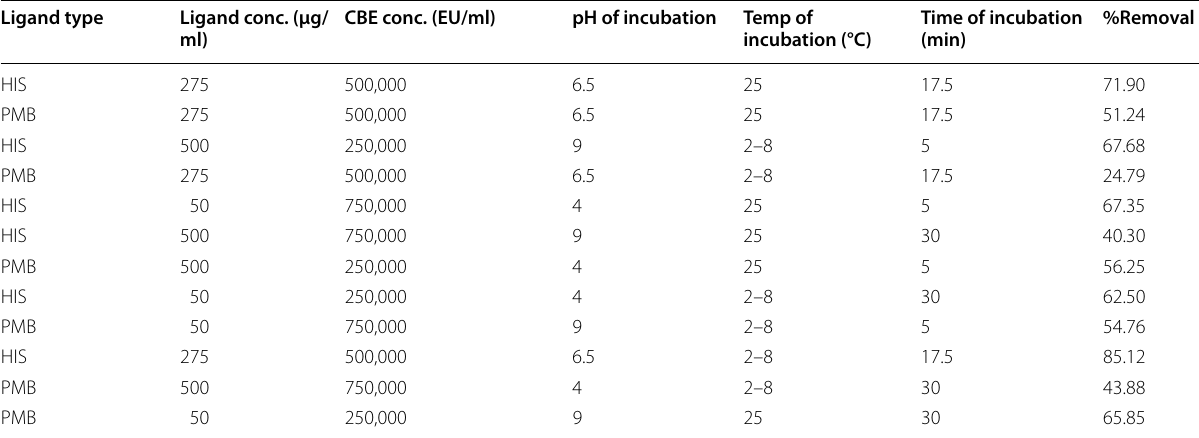
Table 2 Fractional factorial design for optimization of adsorption and results analysis Ligand